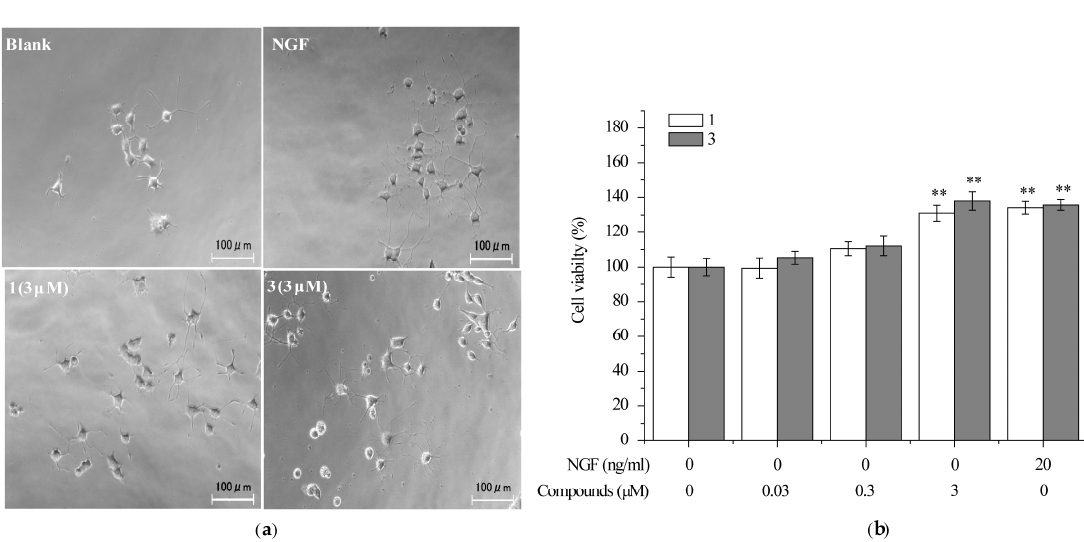
Figure 5. The effect of compounds 1 and 3 on preventing the death of neuronally-differentiated PC12 cells after removal of NGF. PC12 cells were seeded in collagen-coated 96-well plates in normal serum medium for 24 h, then changed to low serum medium (2% HS and 1% FBS) containing NGF (30 ng/mL). After seven days, PC12 cells were exposure to vehicle (0.1% DMSO) as a negative control, NGF (20 ng/mL) as a positive control, or 1, 3 (0.03, 0.3, 3 μ M) for an additional 48 h. Scale bar: 100 μ m. ( a ) Representive cell morphology images and ( b ) cell viability was assessed by MTT assay. Data are expressed as the mean ± SD from three independent experiments. ** p < 0.01 represent significant differences compared with vehicle (ANOVA followed by Dunnett’s test).